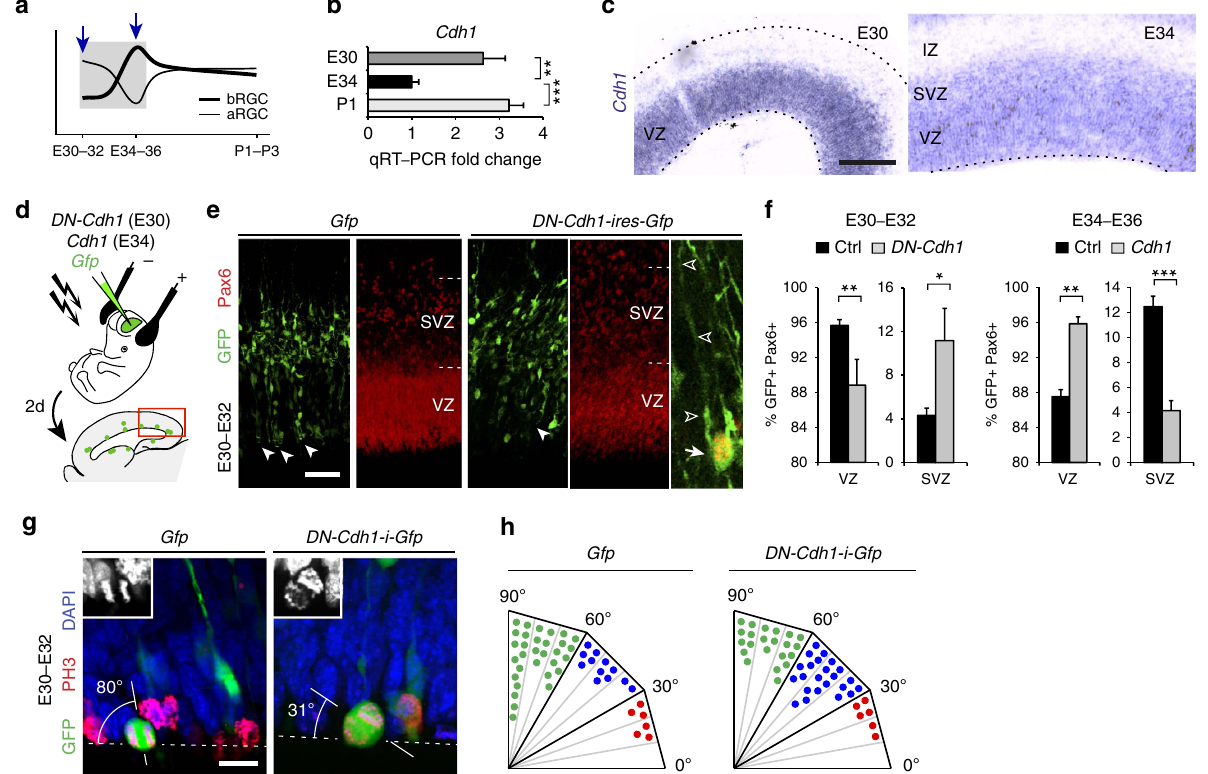
Figure 6 | Onset of the restricted period for bRGC production and OSVZ generation depends on developmental variations of Cdh1 expression. ( a ) Schematic of the early period of bRGC generation from aRGCs. ( b , c ) Candidate gene screening by qRT–PCR revealed Cdh1 as differentially expressed in VZ between E30, E34 and P1 ( b ; mean values þ s.e.m., ** P o 0.01, *** P o 0.001, unpaired t -test), also shown by ISH ( c ). ( d – f ) In utero electroporation of DN- Cdh1 from E30 to E32 increased bRGC production (GFP þ /Pax6 þ cells in SVZ) and decreased aRGCs, whereas overexpression of Cdh1 from E34 to E36 had the opposite effect. In these experiments, GFP þ cells in SVZ were at high density, making unreliable the identification of bRGCs by morphology. Instead, bRGCs were identified as Pax6 þ /GFP þ cells with the cell body in SVZ, and aRGCs as Pax6 þ /GFP þ cells with the cell body in VZ and a distinct apical process. Numbers of cells and embryos analysed are indicated in Supplementary Table 4; * P o 0.05, ** P o 0.01, *** P o 0.001, w 2 -test. ( g , h ) Analysis of cleavage orientation plane of VZ mitoses with respect to ventricular surface (dashed lines) in Gfp - and DN-Cdh1-ires-Gfp- overexpressing cells ( n ¼ 103 cells, Ctrl; 51 cells, DN-Cdh1 ; 2 embryos per group). Insets are details of each mitosis under 4,6-diamidino-2-phenylindole (DAPI) stain. Each dot in h represents 2% of mitoses. Scale bar, 150 m m ( c ); 75 m m ( e ); 15 m m ( g